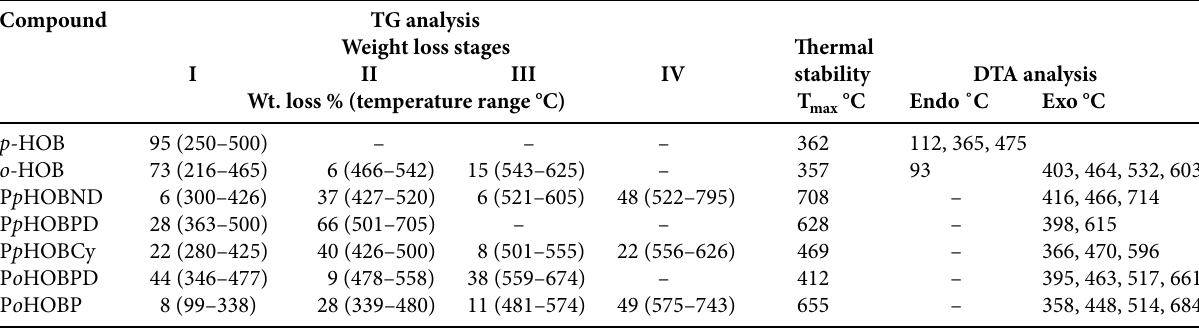
Table 4 . Thermal analysis data of monomers and polymers Compound